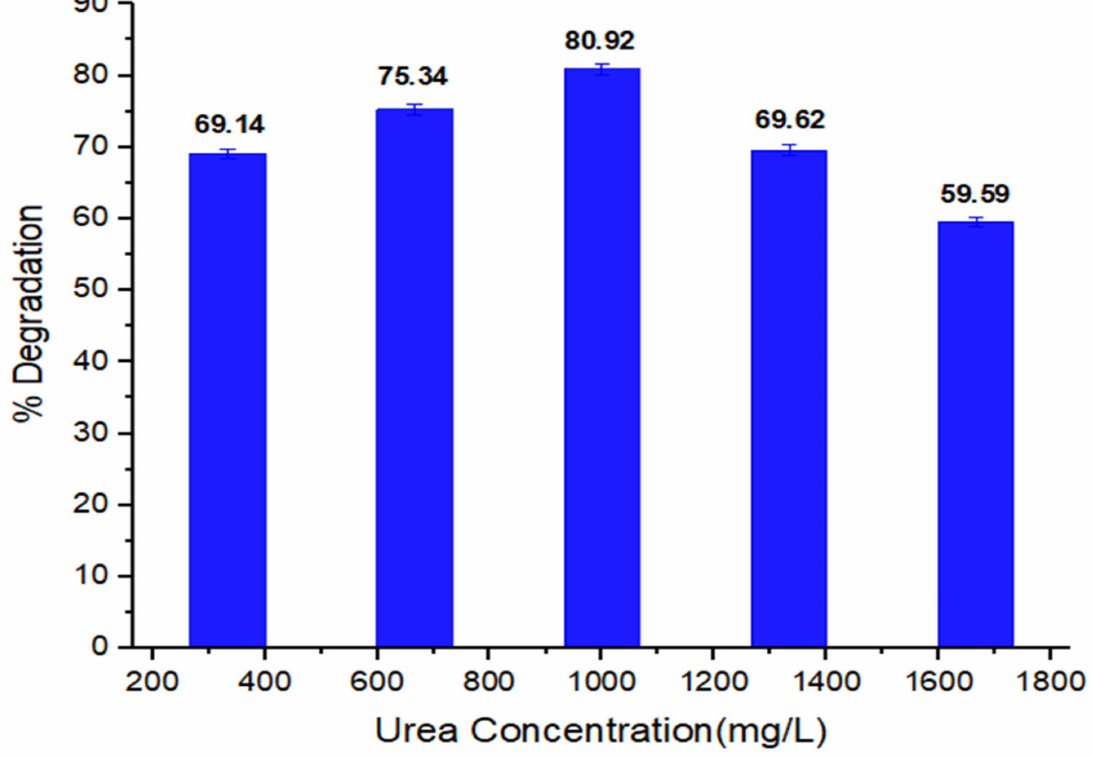
Figure 8. Effect of Urea Concentration (mg/L) on Basic Orange 2 Dye %